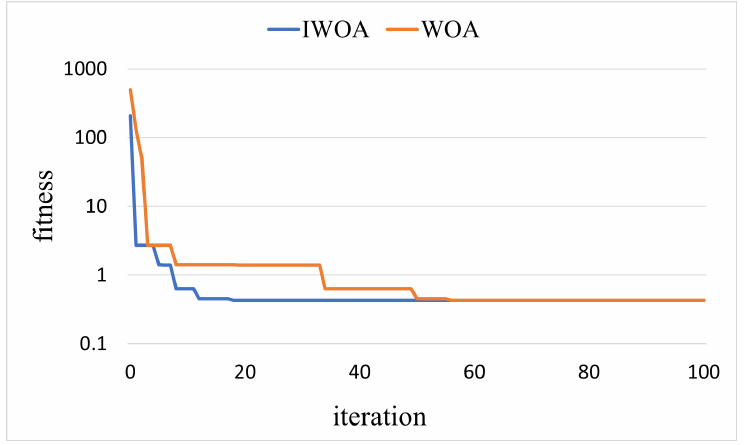
Figure 15. Comparison between the fitness values obtained by the WOA and IWOA during the iterative